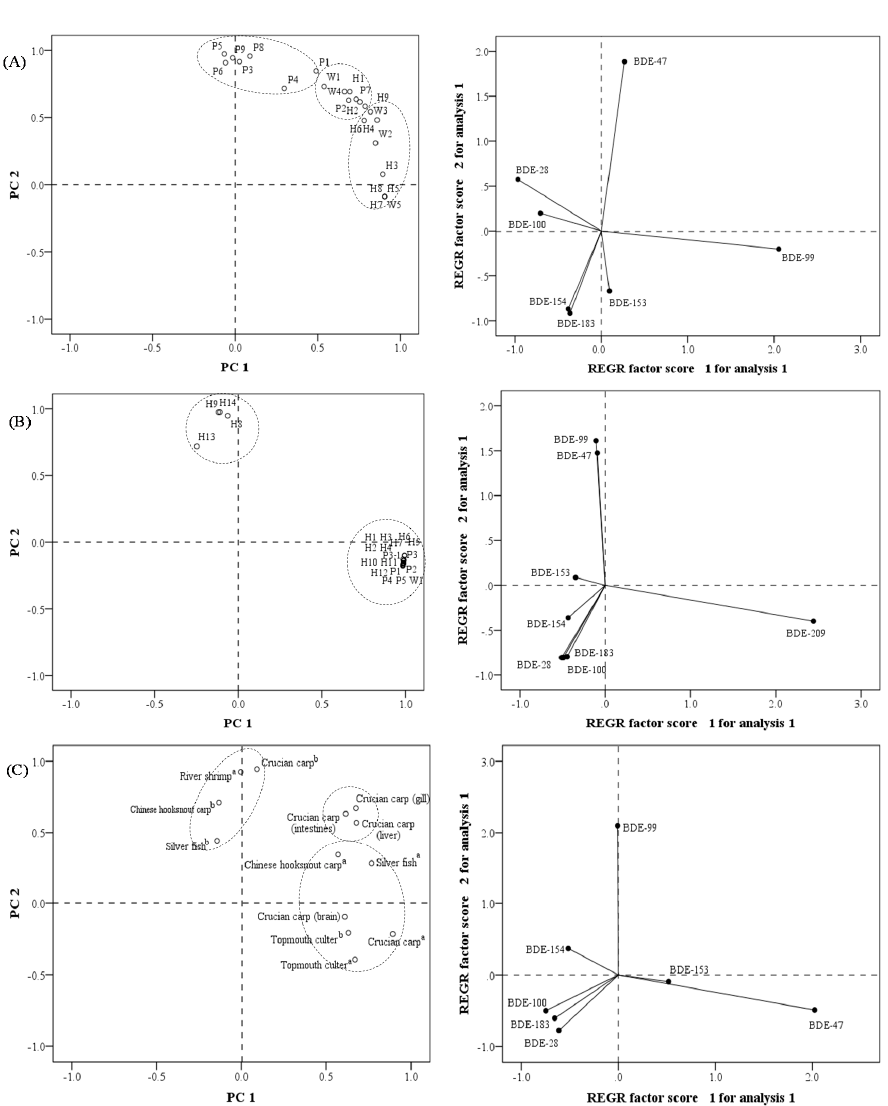
Figure 5. Principal component analysis (PCA) score plot and Regression (REGR) factor score plot for PBDEs in water ( A ), sediment ( B ), and biota ( C ) samples from Chaohu Lake basin ( a Biota samples collected from S1; b Biota samples collected from S2).